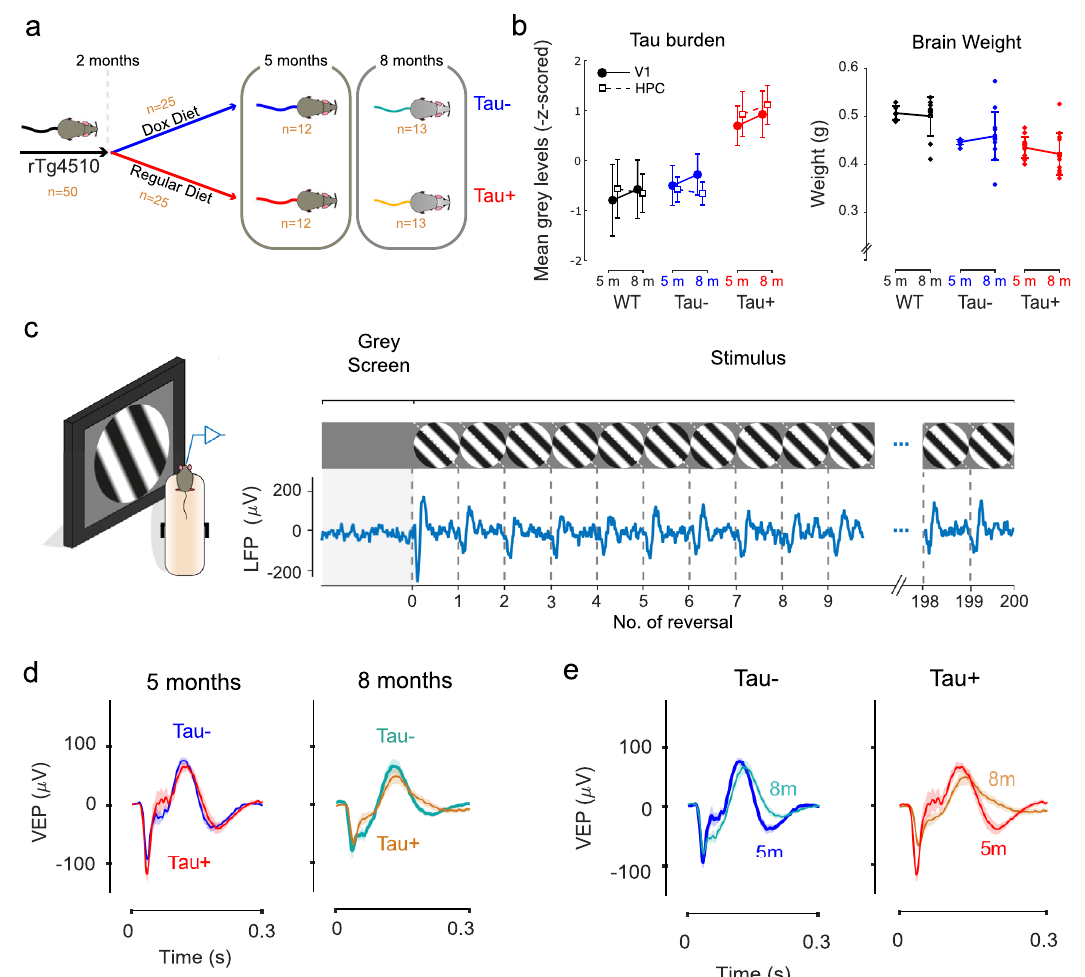
Fig. 1 Visual evoked responses in the primary visual cortex are largely preserved in tauopathy. a 50 rTg4510 mice were used in this study. At 2 months of age, half the rTg4510 mice ( n = 25) were treated with and fed doxycycline (Dox) to suppress the expression of the transgene and arrest further accumulation of Tau (Tau − ). 12 of those Tau − mice were studied at 5 months of age and the other 13 at 8months. Of the 25 mice fed a normal diet (Tau + ), 12 were studied at 5 months and the remaining 13 at 8 months. Data from one 5-month old Tau + mouse was subsequently removed from all electrophysiological analysis because the electrode was found to be placed too deep in the cortex (see “ Methods ” ). b Left, comparison of average tau burden for each group of animals calculated as the mean grey levels within selected regions of interest in V1 and hippocampus (HPC) ( “ Methods ” ). Data are represented as mean ± 2*SEM. Right, comparison of overall brain weights at 5 months (5 m) and 8 months (8 m) timepoints. Data are represented as mean± SEM. c Mice were head- fi xed and allowed to run on a styrofoam wheel. After 5 min exposure to a homogenous grey screen, a full-screen, contrast reversing, sinusoidal grating pattern was presented to the left monocular visual fi eld. The grating reversed every 0.5 s, and the animal was exposed to 10 blocks of 200 continuous reversals, with 30s presentation of a grey screen between blocks. We recorded the local fi eld potential (LFP) in the right primary visual cortex (V1). The LFP trace shown is the average time course across 10 stimulus blocks on one day in one Tau − mouse. Each reversal generated a visual evoked potential (VEP), characterised by an initial negative de fl ection and subsequent positive one. d Average VEP responses on the fi rst day of recording for Tau − and Tau + animals at 5 months (left) and 8 months (right). There was no signi fi cant difference in the size and shape of the VEPs between groups at either age ( p = 0.75, two-way ANOVA). e Average VEP responses for Tau − (left) and Tau + (right) mice obtained at 5 months and 8 months of age. VEPs were slightly reduced, and more sustained, for both Tau − and Tau + mice at 8 months. Shaded area represents the mean±SEM (5-month-old: n = 12 Tau − , n = 11 Tau + ; 8-month-old: n = 13 Tau − , n = 13 Tau + ). The source data underlying this fi gure are available in Supplementary Data 1.